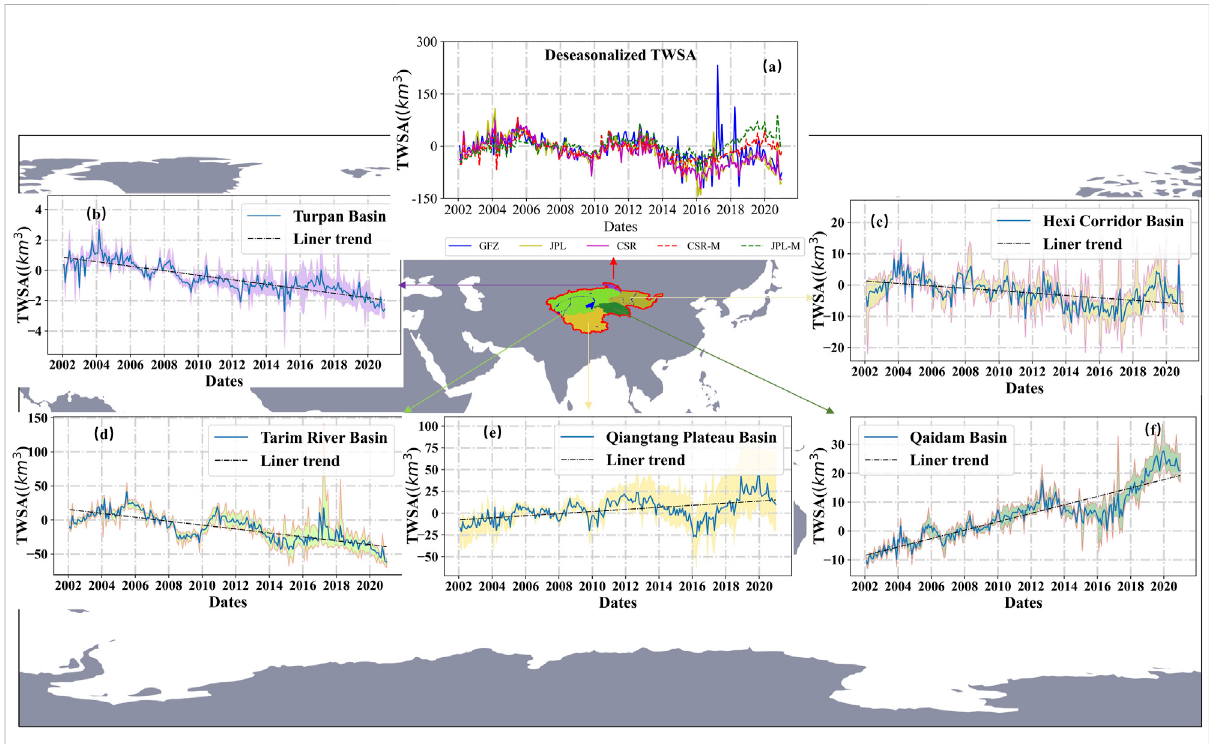
FIGURE 3 Total water storage anomaly (TWSA) trends and Gravity recovery and climate experiment (GRACE) product trend ranges in the Chinese inland basins (CIBs) and its sub-basins. (A) The comparison of deseasonalized TWSA in the CIBs; (B – F) the TWSA trend range in the Turpan Basin, Hexi Corridor Basin, Tarim Basin, Qiangtang Basin, and Qaidam Basin, respectively. The black dashed lines indicate their linear